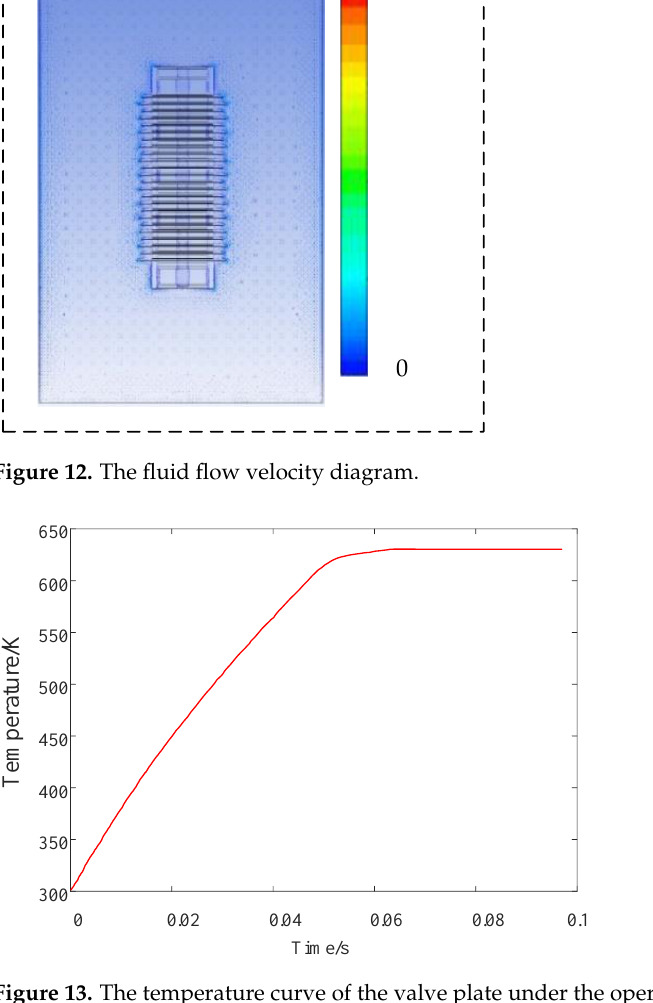
Figure 13. The temperature curve of the valve plate under the operating condition of fault f18.